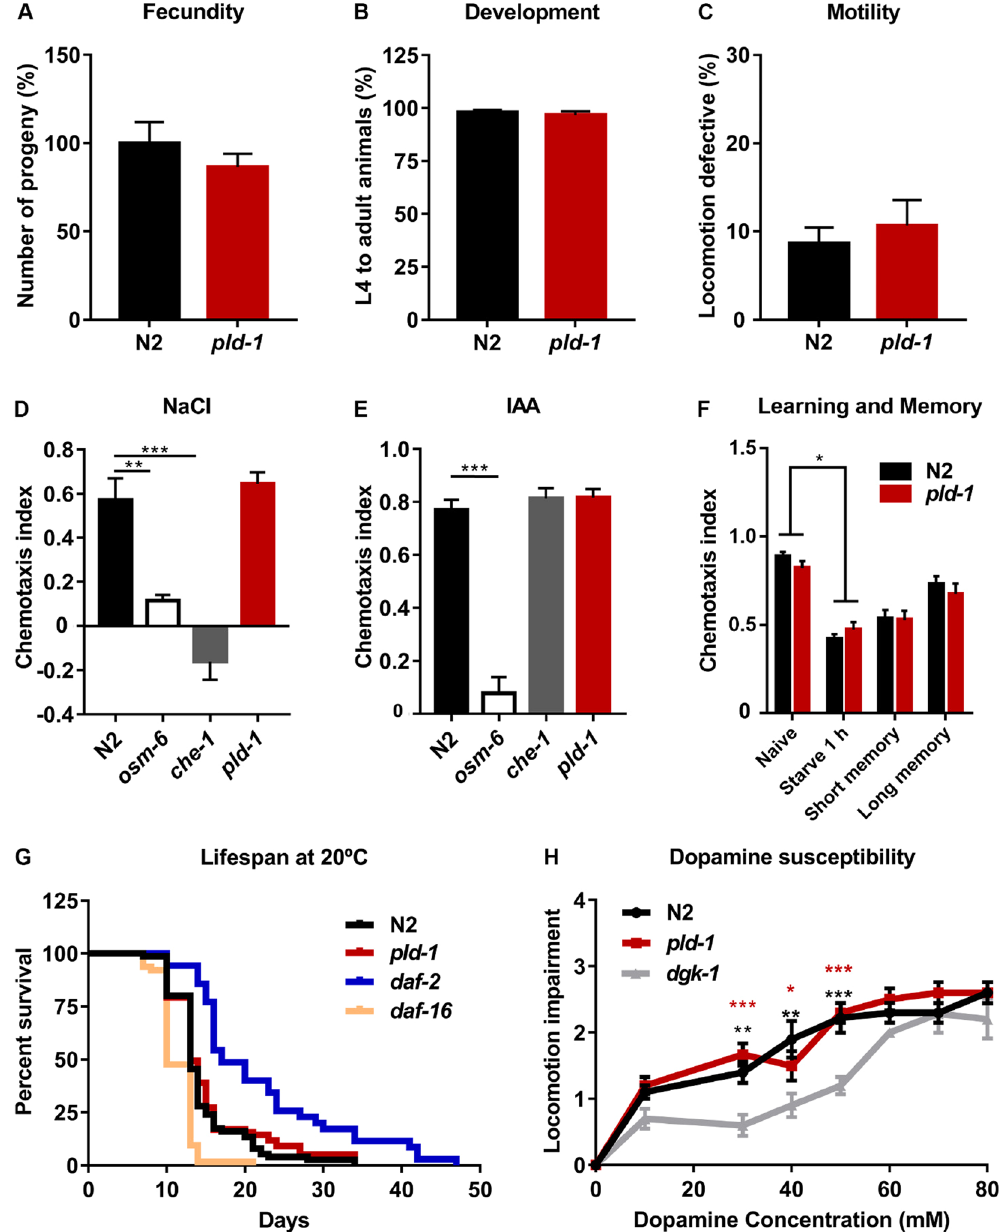
Figure 2. pld-1 animals show no major phenotypic alterations. ( A – C ) Effect of PLD ablation on C . elegans egg-laying, development and locomotion behavior. ( A ) Number of progeny of adult hermaphrodite N2 and pld-1 animals for 5 h. The progeny of 10 worms was counted per experiment (n = 3). ( B ) Percentage of L4 to adult N2 and pld-1 animals after 48 h post egg laying. At least 150 animals were averaged per dataset (n = 3). ( C ) The percentage of locomotion defective age-synchronized adult animals (day 3 post-hatching) was measured by scoring the animals that remain inside a 10 mm circle, 1 min after being placed on its center. The number of animals used per trial was 10 (n = 3). ( D , E ) pld-1 worms have a normal chemotaxis response. Chemotaxis response to NaCl and isoamyl alcohol (IAA) was evaluated in N2, pld-1 , che-1 and osm-6 animals. Mutant strains unable to detect NaCl ( osm-6 and che-1 ) and IAA ( osm-6 ) were used as negative controls. Three independent experiments were performed (n = 200 worms per assay). ( F ) pld-1 animals have no deficit in an associative learning task. N2 and pld-1 short-term and long-term associative memory profile after 1 h and 24 h of conditioning. Representative example of three independent experiments is shown (n = approximately 100 worms per chemotaxis assay plate). ( G ) pld-1 worms have a normal lifespan. Kaplan-Meier survival curve of pld-1 worms, show no difference in the median lifespan. Survival rate was scored everyday and is expressed as percentage of survival. daf-2 and daf-16 strains were used as long and short-lived controls, respectively. The data results from the analysis of 100 worms per strain in 3 independent experiments. ( H ) Dose-response curves measuring paralysis induced by exogenous dopamine. Locomotion impairment of animals moving 30 min after being placed on agar plates containing the indicated concentrations of dopamine is shown. N2 and